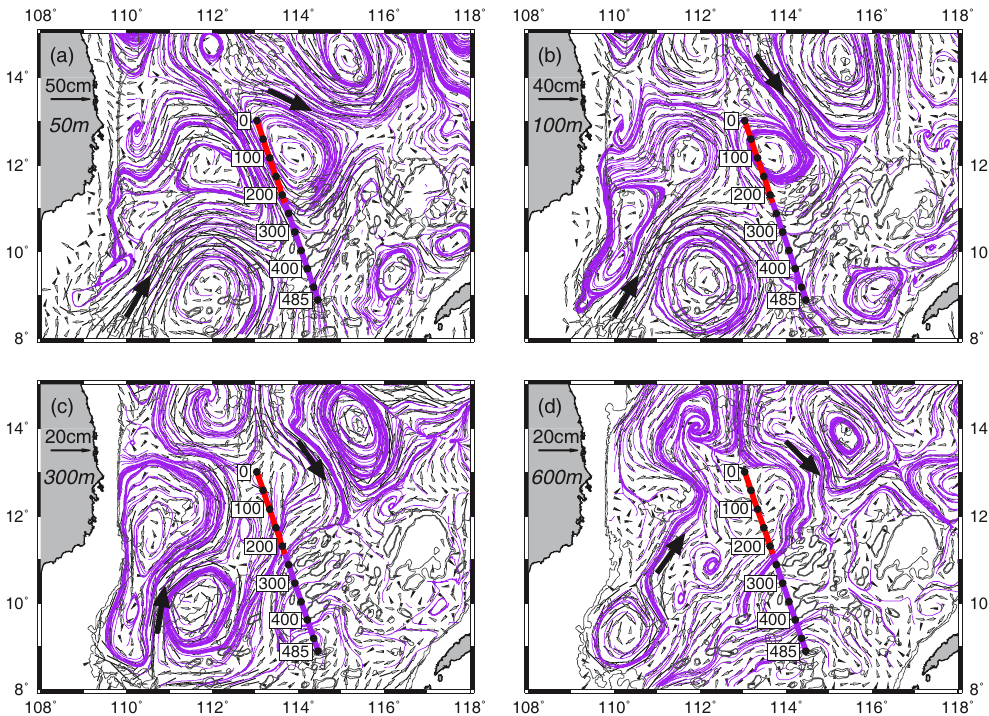
Fig. 5. HYCOM simulated velocities at different depths in the southern SCS on 30 May 2009. The purple lines are the streamlines de- rived from the velocities. Black arrows show the current directions at some key spots. The seismic transect with labelled distances is also superimposed.